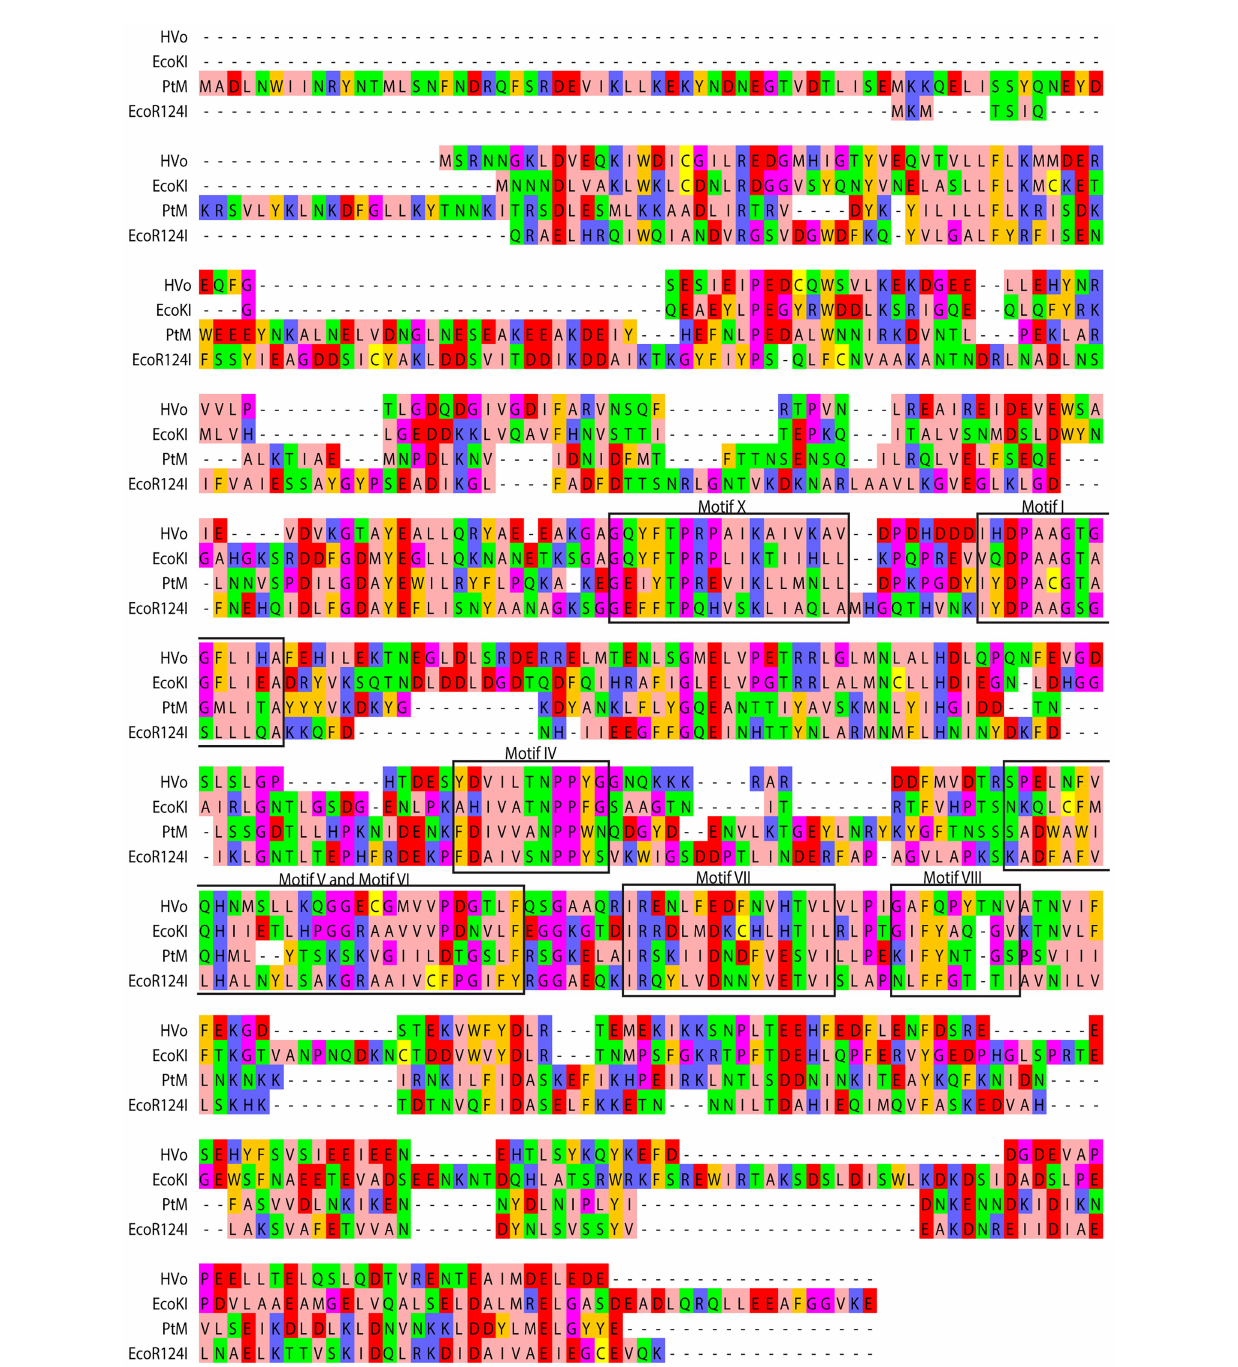
FIGURE 2 Comparison of derived amino acid sequence of M subunit of M.PtoI with the sequences of M subunits of other Type I modification methylases: Clustal Omega analysis viewed using Jalview multiple alignment editor (Sievers et al., 2011). The conserved motifs are demarcated in black rectangular boxes. Colors are indicative of the physicochemical properties of the amino acids. Pink, aliphatic/hydrophobic; orange/ochre, aromatic; purple, glycine/ proline; dark blue, basic; green, hydrophilic; red, acidic; yellow,